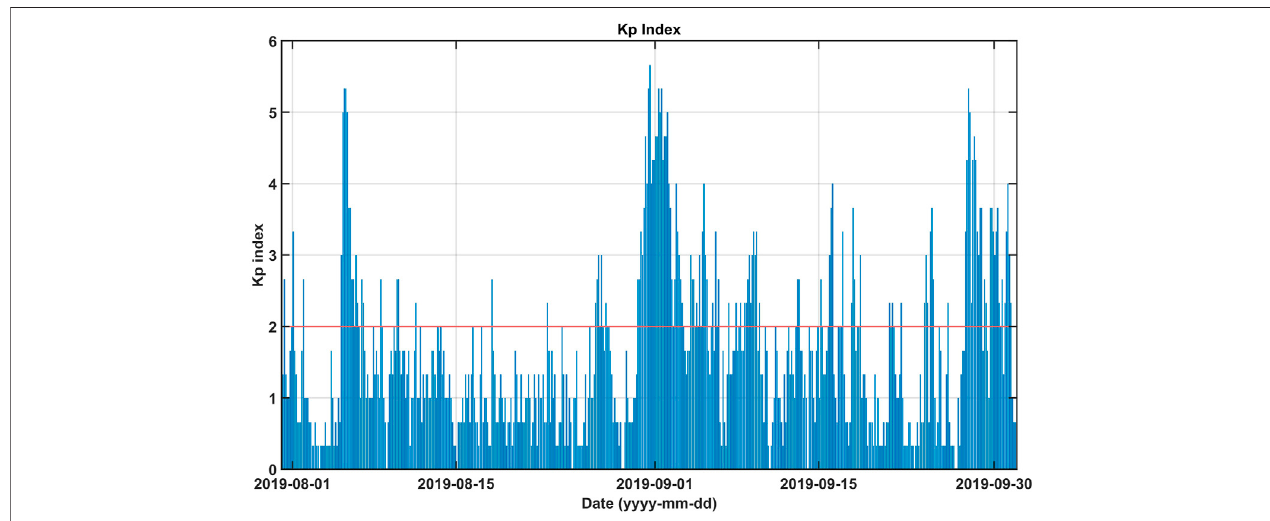
FIGURE 1 | Kp index variation for the period from 31 July 2019 to 30 September 2019.